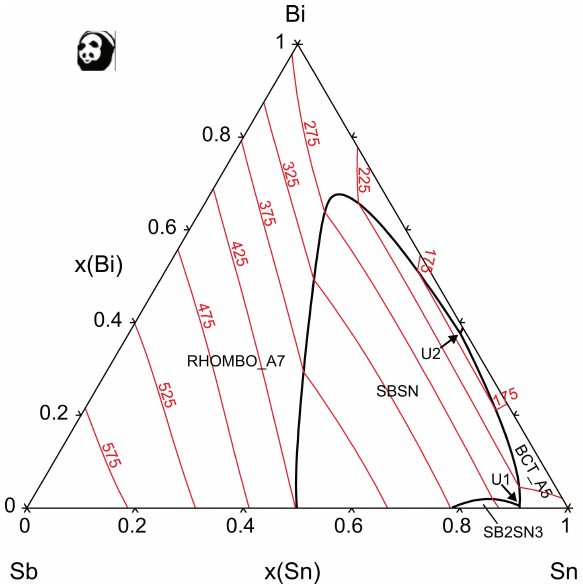
Figure 8. Liquidus surface projection of the ternary Bi-Sb- Sn